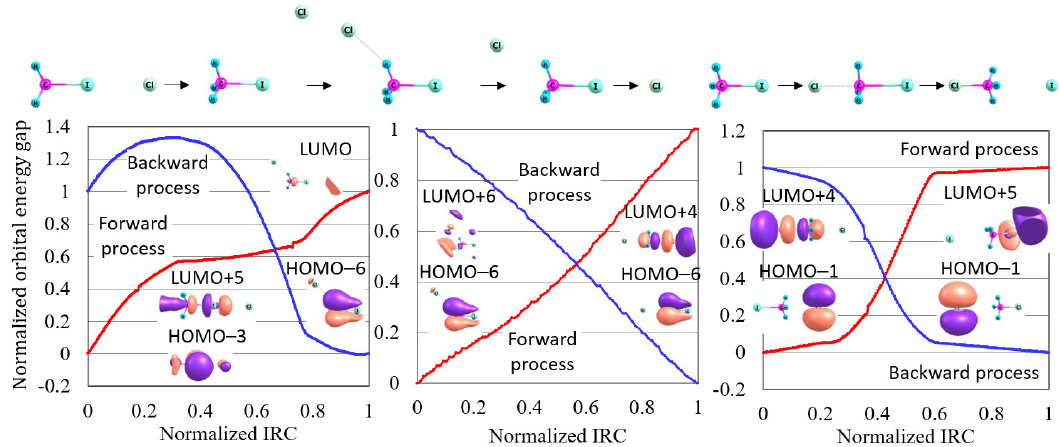
Figure 4. The normalized reaction diagrams of the three steps of the Cl − + CH 3 I → CH 3 Cl + I − reaction given in the potential energy curve of Figure 3, which is calculated by LC-BOP+LRD/Def2-TZVPD. The images of the molecular orbitals mainly contributing to each reaction process are also